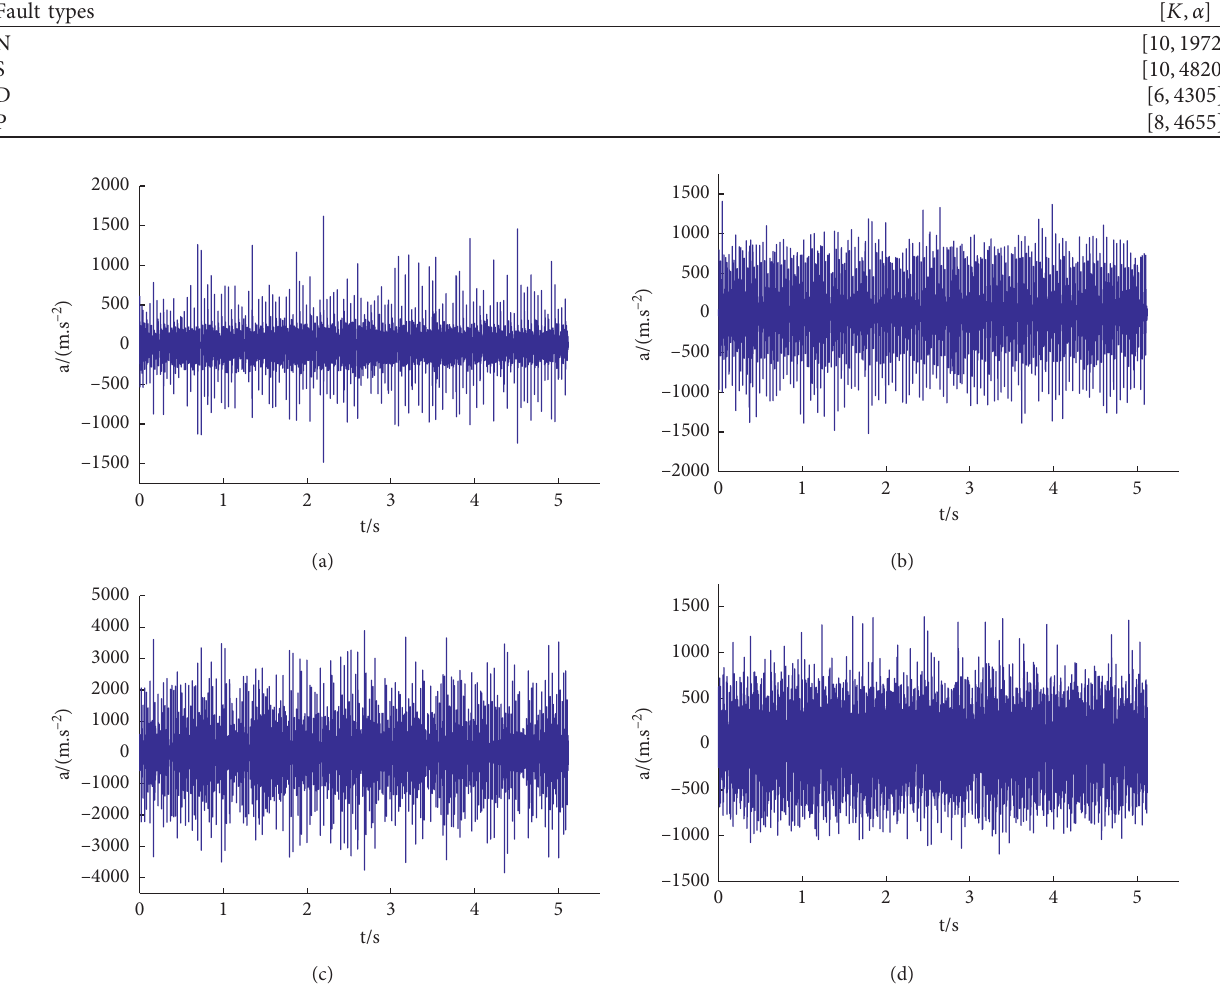
Figure 10: Time domain waveforms of denoised vibration signals. (a) Normal working state. (b) Single plunger loose slipper. (c) Double plungers loose slipper. (d) Piston shoe